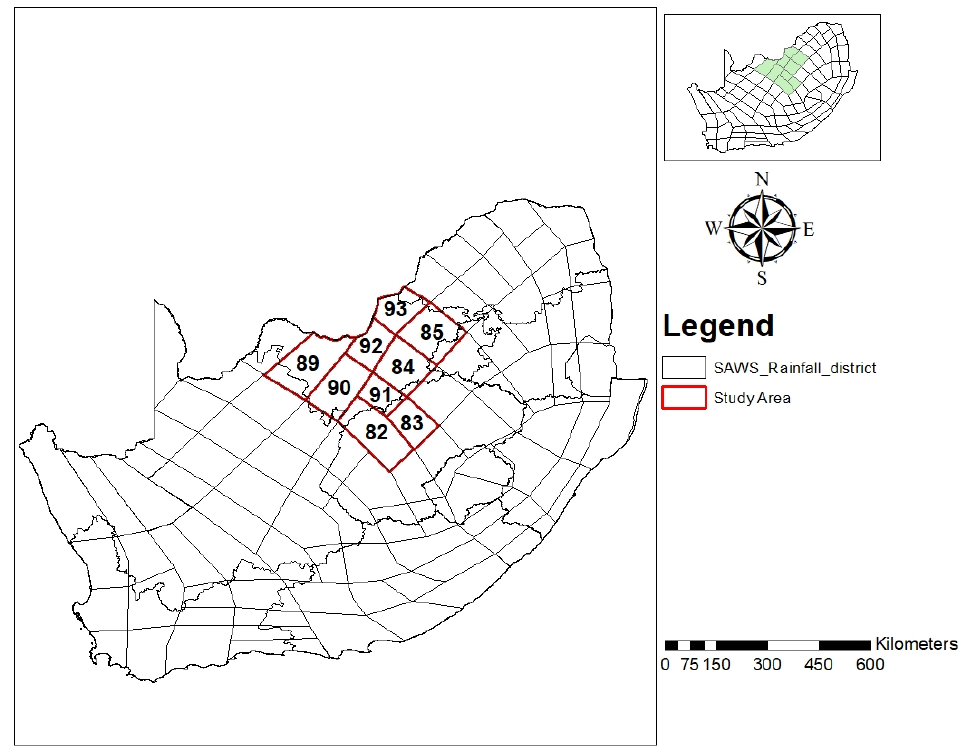
Figure 1. Study area showing rainfall districts for South Africa with provincial borders [23], showing the selected districts with red polygons.